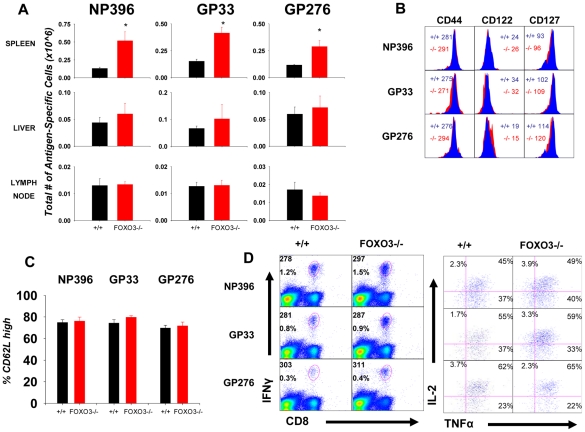
FOXO3 deficiency leads to a tissue-specific increase in the size of the CD8 T cell memory compartment with no effect on the quality of memory CD8 T cells.(A) +/+ and FOXO3−/− mice were infected with LCMV, and virus-specific CD8 T cells were quantified by flow cytometry at 180 days PI by staining with anti-CD8 and MHC-I tetramers. Data are from two independent experiments with 5–7 mice/group/experiment; error bars represent the SEM and * indicates statistical significance at p<.03. (B) At 180 days PI, LCMV-specific CD8 T cells in +/+ and FOXO3−/− mice were examined for expression of CD44, CD122 and CD127. Representative plots are gated on tetramer-binding CD8 T cells. The numbers represent MFI of staining for each marker in +/+ or FOXO3−/− mice. (C) Splenocytes were stained with MHC-I tetramer, anti-CD8, and anti-CD62L. The percentage of LCMV-specific CD8 T cells with high expression of CD62L was determined by flow cytometry and graphed accordingly. Error bars represent the S.E.M from at least 3 independent experiments with 4 mice/group/experiment. (D) Cytokine production by LCMV-specific memory CD8 T cells was assessed by intracellular cytokine staining. Representative dot plots are gated on total splenocytes, with the top number indicating the MFI for IFNγ and the bottom number denoting the percentage of total splenocytes that are CD8 and IFNγ positive (left). The percentage of double positive (IFNγ+ve and IL-2+ve or IFNγ+ve and TNFα+ve) and triple positive (IFNγ+ve, IL-2+ve, and TNFα+ve) populations (right) is shown for the indicated epitope.